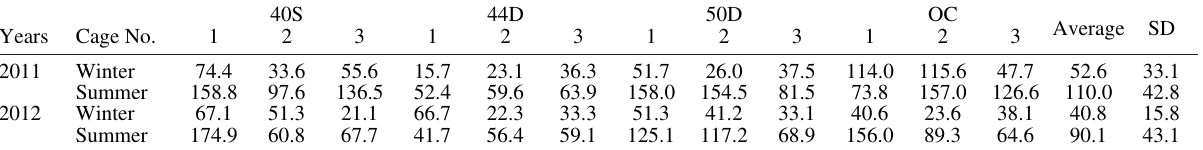
Table 3. – Red mullet. Summary data on fish escaping from the test and open codends (n, total fish number in cages; F